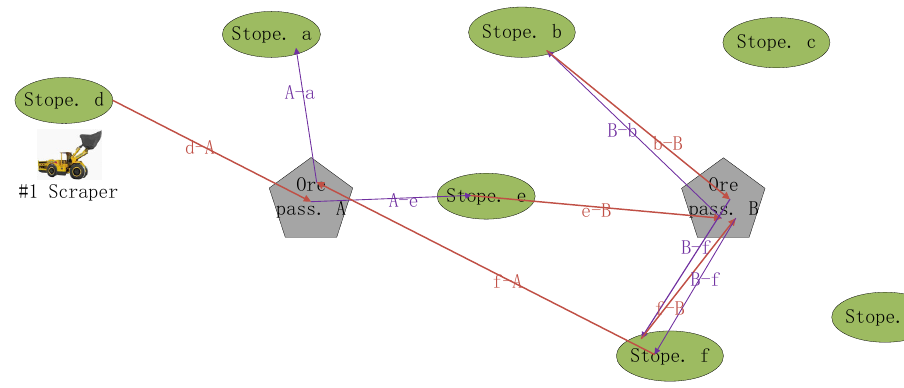
Figure 8. Operation route of the #1 scraper during a certain period of time.